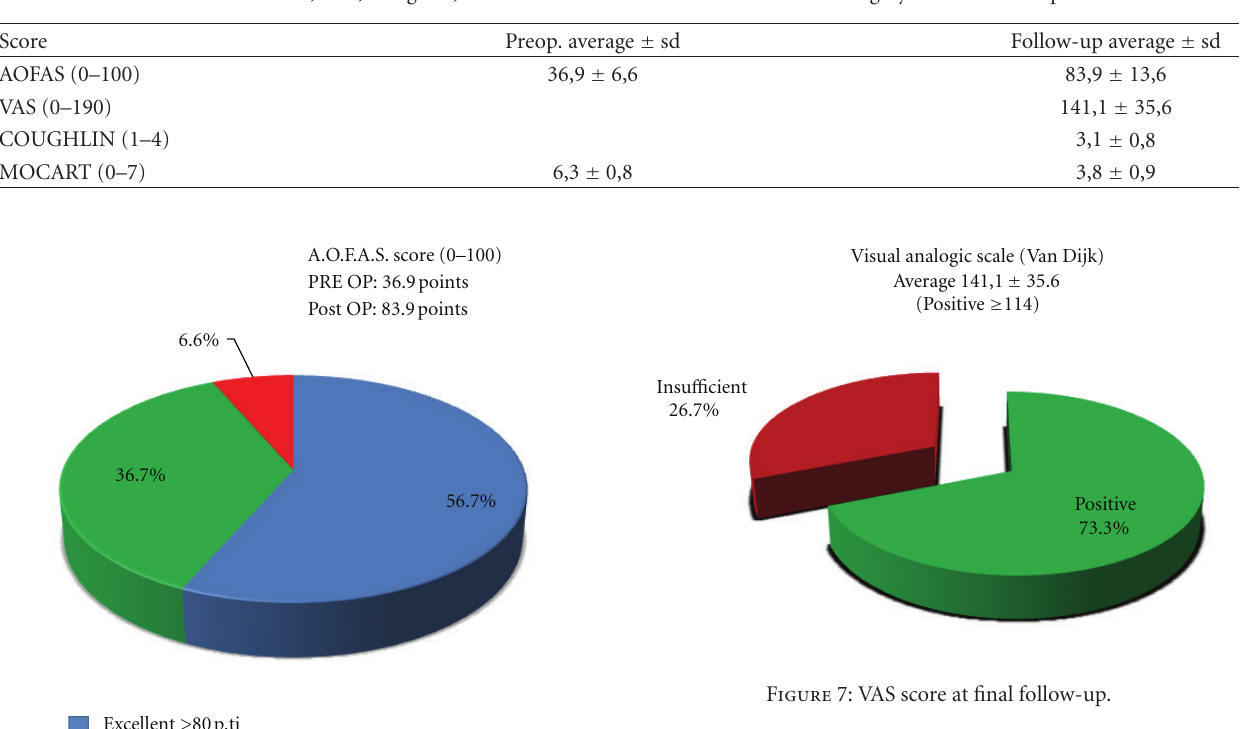
Table 2: AOFAS, VAS, Coughlin, and MOCART scores’ mean values before surgery and at follow-up.